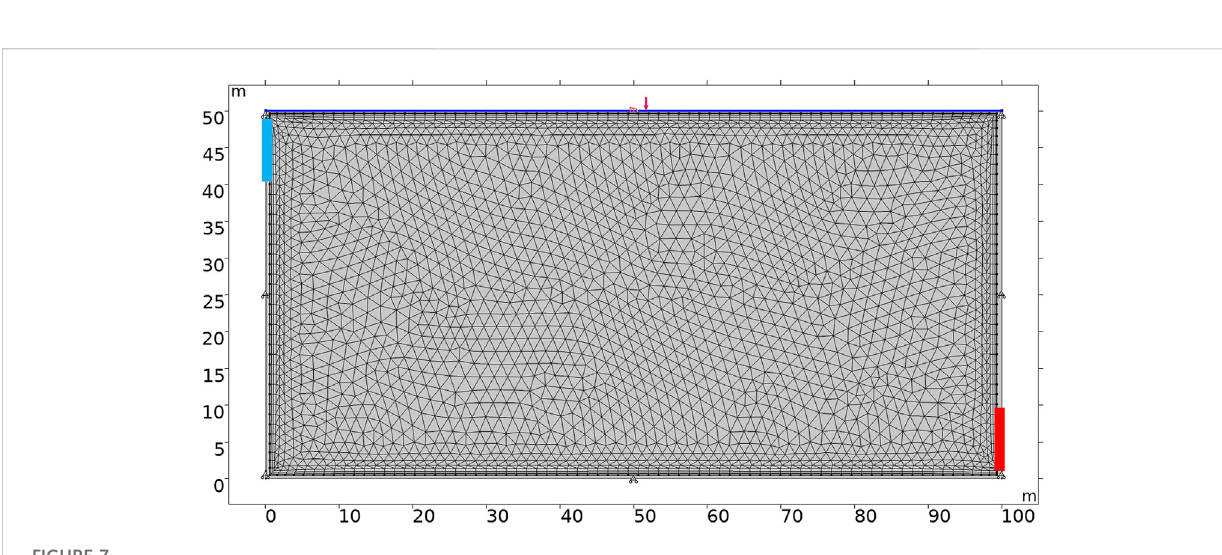
FIGURE 7 Geometric model of large-sized heat storage system.